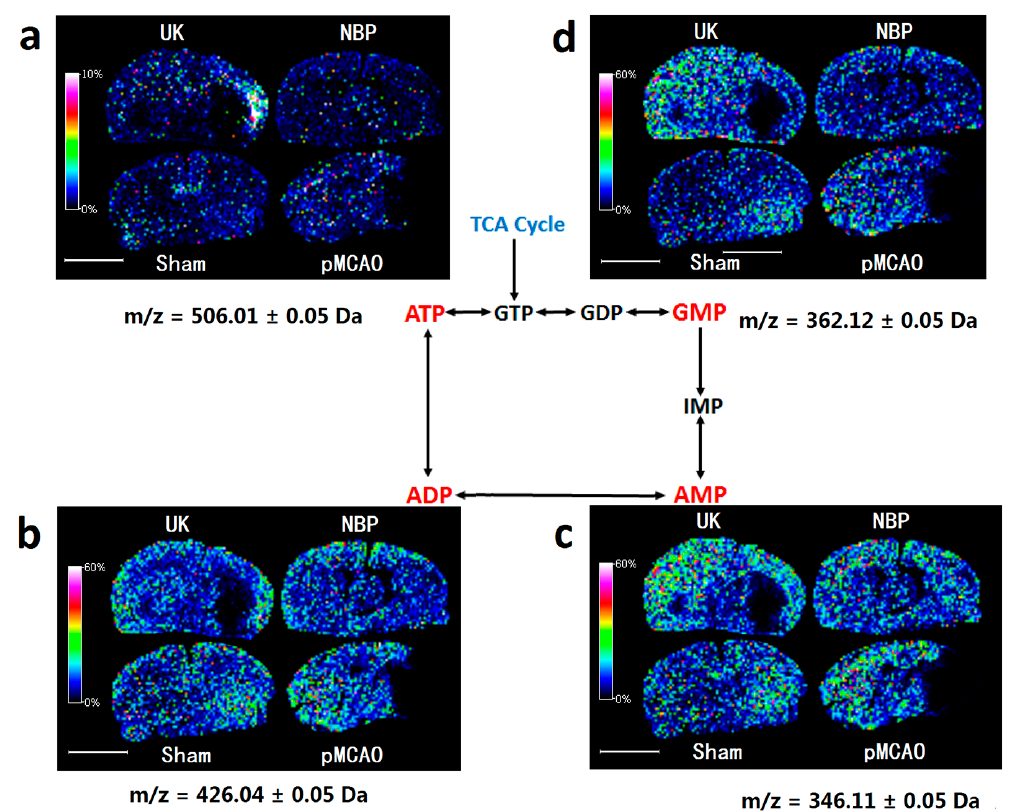
Figure 5. Dl-3-n-butylphthalide increased the rate of ATP metabolism in the pMCAO rat model. MALDI–TOF–MS imaging of ( a ) ATP; ( b ) ADP; ( c ) AMP; and ( d ) GMP. The spatial resolution was set to 200 µm. m/z: mass-to-charge ratio. Scale bar = 5 mm. n = 3. Sham: sham surgery group; pMCAO: pMCAO group; NBP: dl-3-n-butylphthalide-treated group; UK: urinary kallidinogenase-treated group. 2.5. Dl-3-n-butylphthalide Improved the Levels of Metabolites Involved in the Glutamate-Glutamine Cycle and the Malate Aspartate Shuttle in the Rat Model of pMCAO As shown in Figure 6, compared with the sham surgery group, the glutamic acid, glutamine, aspartate and N -acetylaspartate contents decreased in the right cortex and striatum of rats in the pMCAO group. Dl-3-n-butylphthalide and urinary kallidinogenase obviously increased the levels of glutamate, glutamine, aspartate, and N -acetylaspartate. Analysis in MRM mode of LC–MS/MS further showed relatively decreased levels of N -acetylaspartate at the infarct site, which dl-3-n-butylphthalide treatment further increased (Figure 4b, Supplementary Table